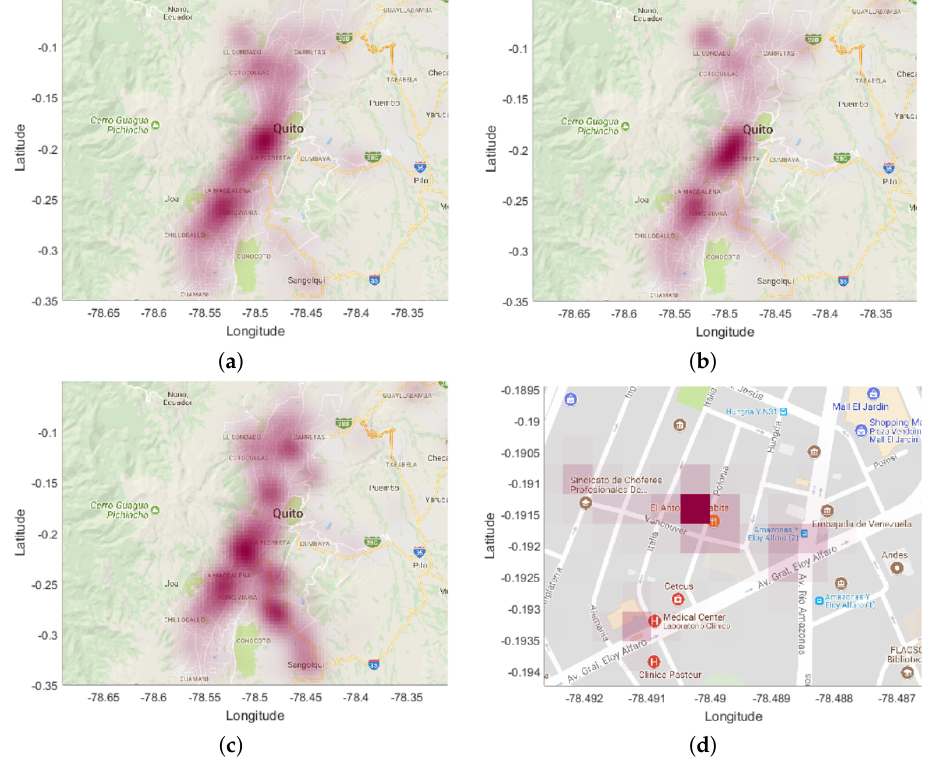
Figure 4. Overview of emergency events in the city of Quito during 6 December, as represented by their Parzen estimation for ( a ) police; ( b ) health; and ( c ) transit services, using a global width for all of these; ( d ) representation of event density using Parzen kernel density deviation via diffusion (KDD) for police on a short scale over Mariscal